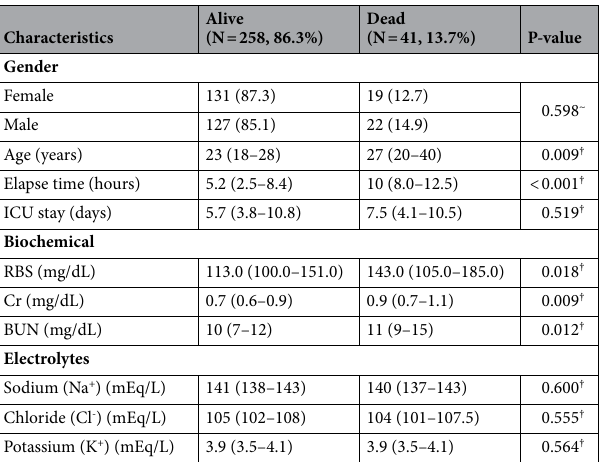
Table 1. Descriptive statistics of baseline characteristics with ICU-mortality. IQR interquartile range (25th–75th percentile); † Wilcoxon Rank Sum Test; ~ Chi-square Test, ICU intensive care unit, RBS random blood sugar, Cr creatinine, BUN blood urea nitrogen.